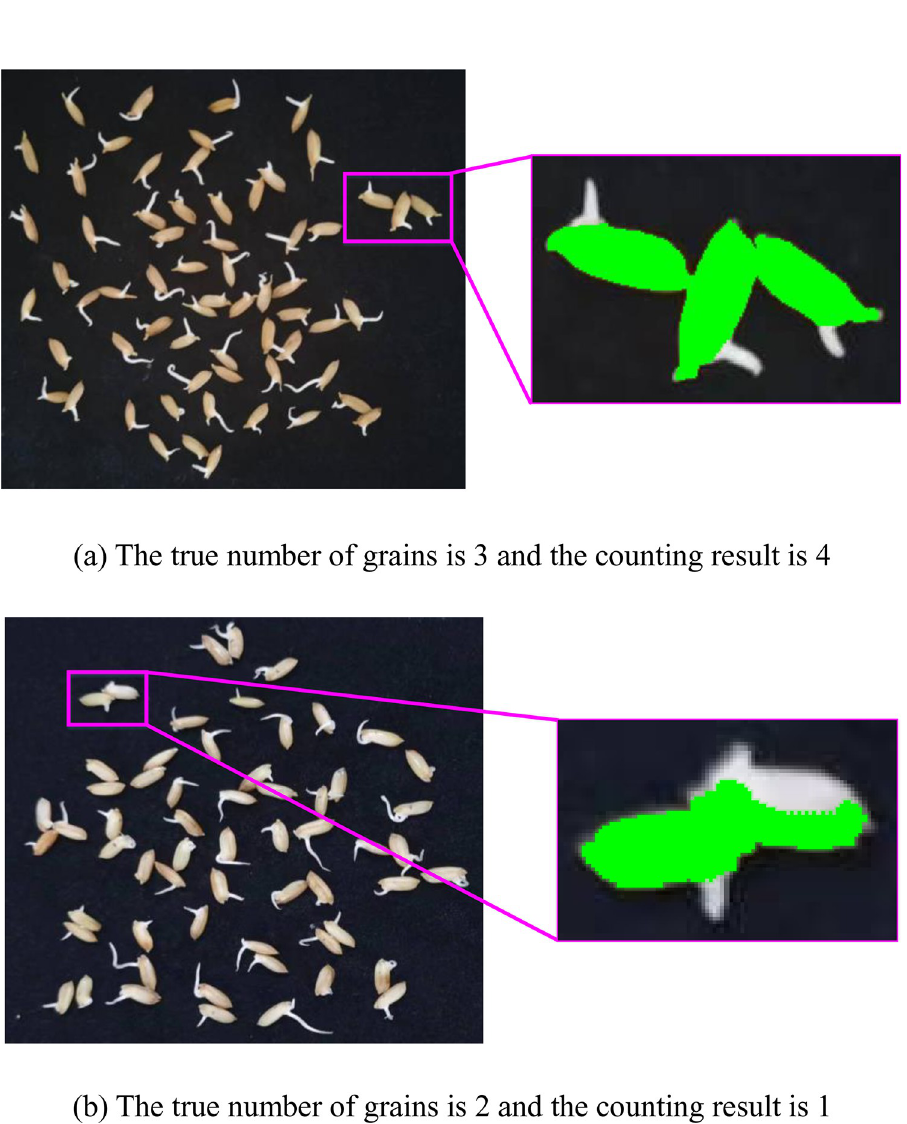
Fig 11. The area of grain connected regions.